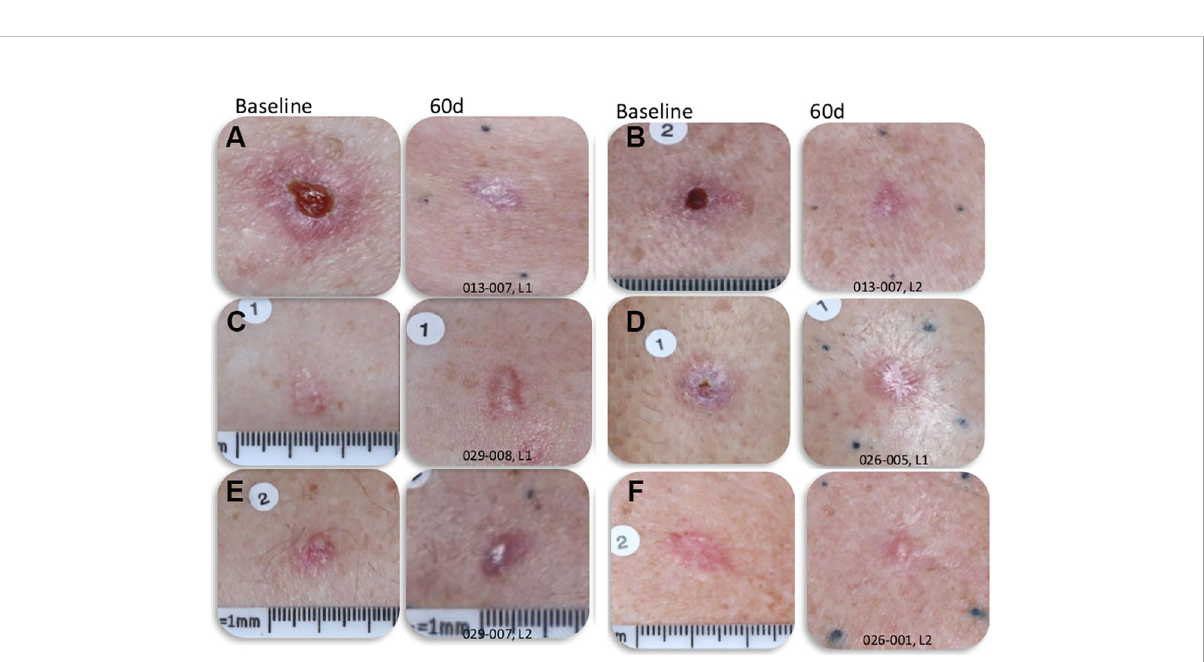
FIGURE 4 Photographs of BCC lesions before and 60-days post-CellFX Treatment. The scar in the treated lesions correlates well with the site of biopsy that was completed before CellFX treatment and regions outside of the biopsy that were treated with CellFX System showed minimal to no scarring. (A – F) each represents a separate lesion shown before and 60d after treatment.